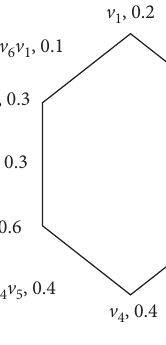
Figure 5: Fuzzy graph of G .